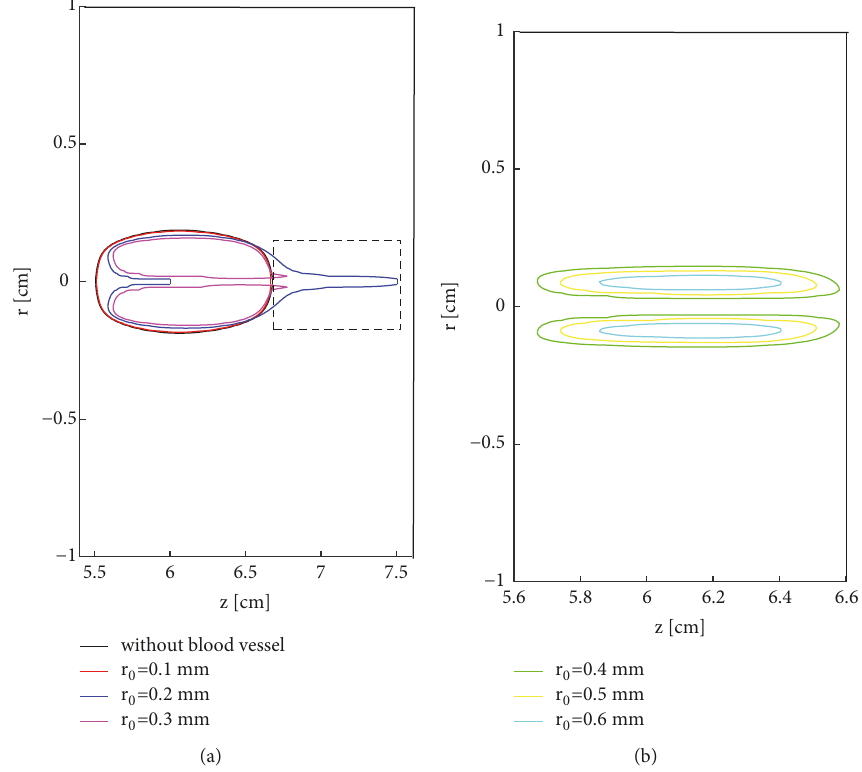
Figure 9: Thermal lesion region in space 𝑟, 𝑧 ∈ Ω with different radius of blood vessel for 𝑝 0 = 2 × 10 5 𝑝𝑎 , 𝑢 𝑎 V 𝑒 = 5𝑐𝑚/𝑠 , 𝑑 = 0 𝑚𝑚 , 𝜏 = 1.756 𝑠 , 𝑓 = 1 𝐻𝑧 , 𝑓𝑎𝑐 = 0.5 , 𝑡 = 2 𝑠 . 𝑝 ℎ